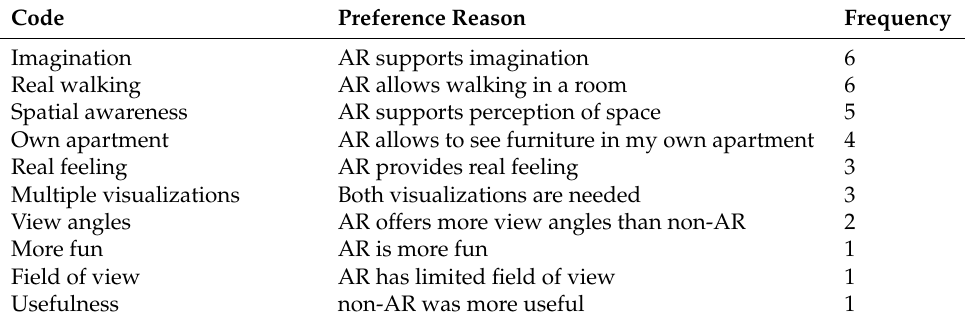
Table 2. Qualitative analysis of user preferences. Codes were collected from users’ preference explanations (preference reasons). Frequency indicates the number of users who mentioned given code. The preference reasons are ordered according the frequency of